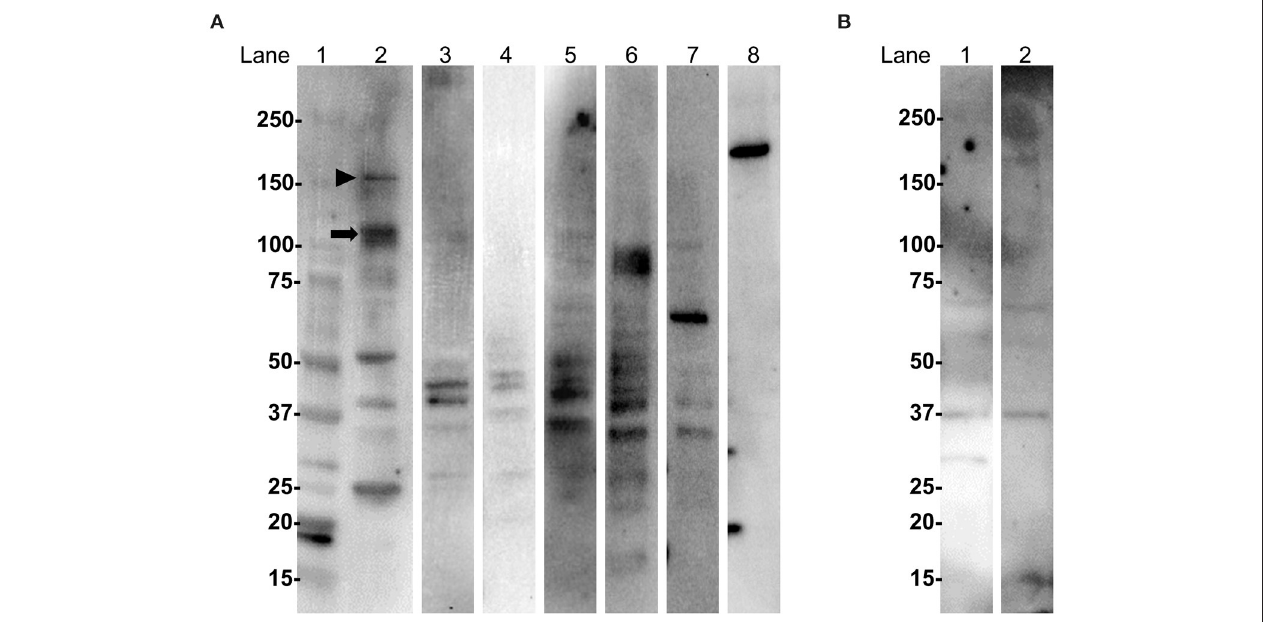
FIGURE 4 | WB with IgG from MS patients and anti-oligodendrocyte antibodies using extracted mouse cerebellum and sciatic nerve proteins. (A) WB analysis of extracted mouse cerebellum. Lane 1: molecular weight markers; lanes 2, 3, 4, and 5: IgG from Cases 1, 2, 3, and 4 with anti-oligodendrocyte antibodies in Figure 1 , respectively; lane 6: IgG from a RRMS patient without anti-oligodendrocyte antibodies; lane 7: IgG from a HC; lane 8: commercial anti-Nogo A antibody. IgG from Case 1 (lane 2) bound to proteins of approximately 110 kDa (arrow) and 150 kDa (arrowhead). IgG from Cases 2 (lane 3), 3 (lane 4), and 4 (lane 5); IgG from a RRMS patient without anti-oligodendrocyte antibodies (lane 6); or a HC (lane 7) did not bind to specific protein bands. The commercial anti-Nogo A antibody (lane 8) showed a 180-kDa immunoreactive band, which suggested that the target autoantigens of IgG from Cases 1, 2, 3, and 4 were different from Nogo-A. (B) WB analysis